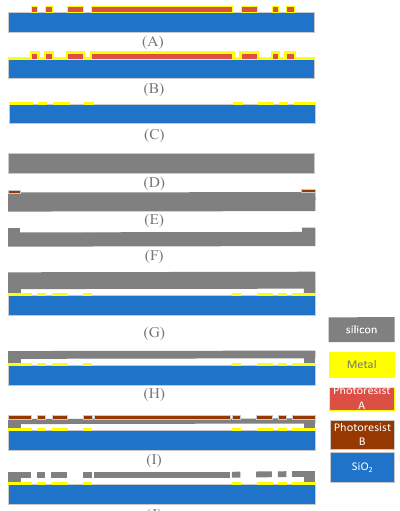
Figure 17. The fabrication process of the TAG. ( A ) After cleaning and drying the glass wafer, the glass substrate was spin-coated with AZ4620 photoresist and baked. After baking, the mask was aligned with the glass substrate and irradiated with a UV light source to pattern the glass substrate. ( B ) The electrical connection layer was formed by sputtering Cr/Au on the glass substrate to a thickness of 200 nm. ( C ) Photoresist was removed with an organic solvent (usually ethanol and acetone). ( D , E ) A 4-inch, 400- μ m-thick <111> silicon wafer was used, and AZ4620 was coated and patterned on the back side of the wafer. ( F ) DRIE was used to etch a 2 μ m depth for preparing the anchor of the gyroscope. The residual photoresist was removed at the end of the etching process. ( G ) The silicon and metallized glass wafers were anodically bonded on an EVG510 bonding machine with a bonding temperature of 400 °C and a bonding voltage of 800 V. ( H ) After step G, the silicon wafer thickness was thinned to 100 μ m. ( I ) Photoresist was applied on the front side of the silicon wafer and a second etching is performed with an etching depth of 100 μ m. ( J ) Finally, etching was completed and the structure is released.